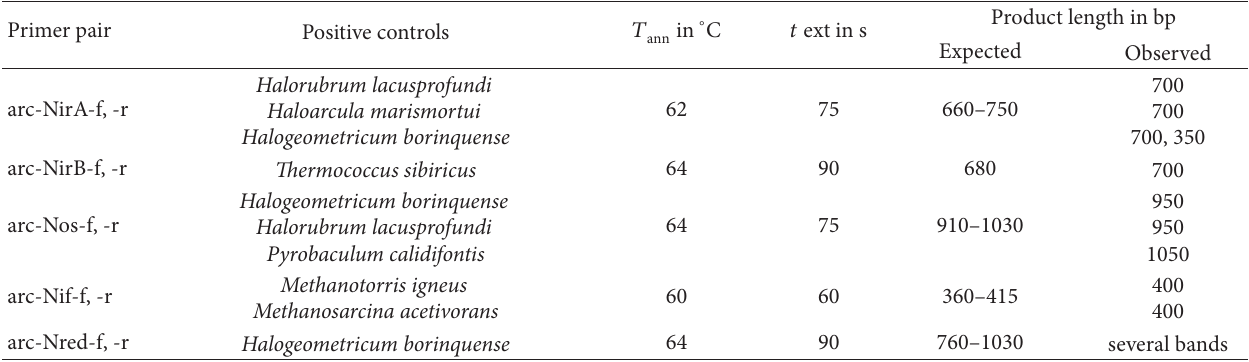
) and extension time ( ext).Expected lengths of the ampli�cation ann 𝑡𝑡 𝑇𝑇